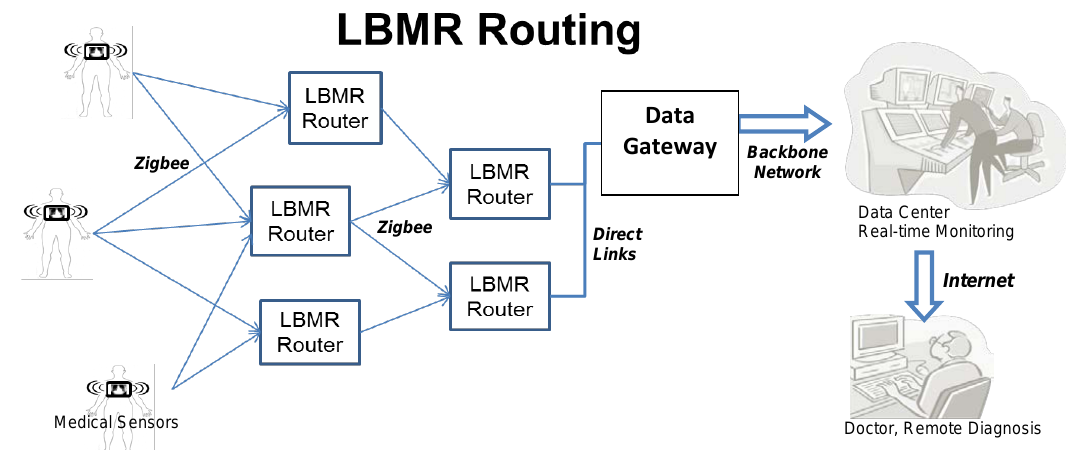
Figure 1. Example scenario of LBMR routing for real-time medical